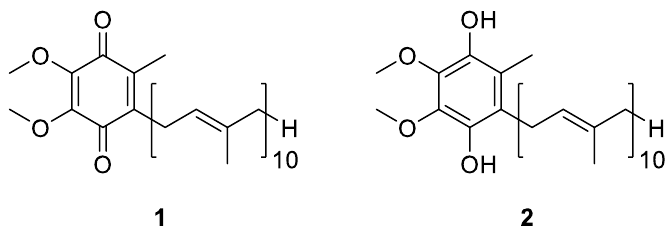
Figure 1. Chemical structures of ubiquinone ( 1 ) and ubiquinol ( 2 ).